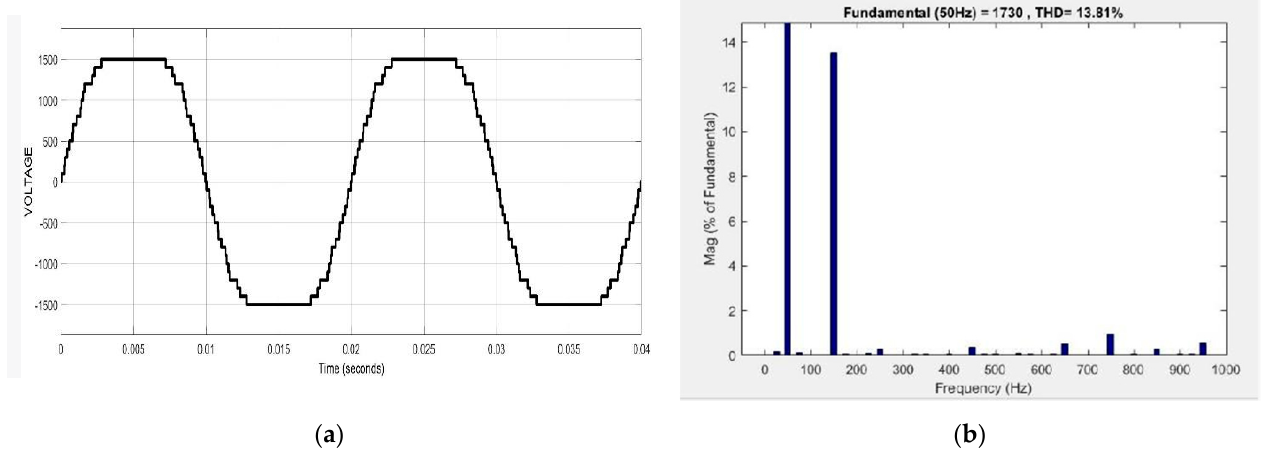
Figure 29. In this fi gure, ( a ) represents IGWO waveform and ( b ) represents the THD spectrum of IGWO.